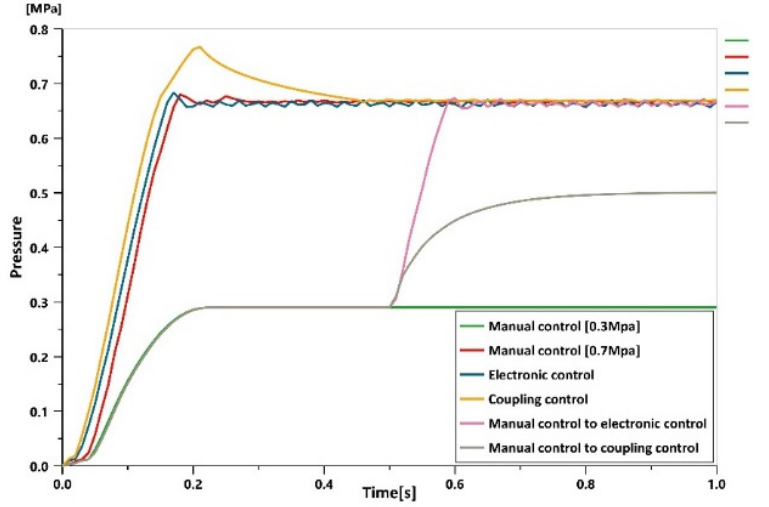
Table 6. Parameters of the simulation models for the pressure regulation characteristics of the APRV of the different struc- tural configurations in the ECPBS of commercial vehicles.